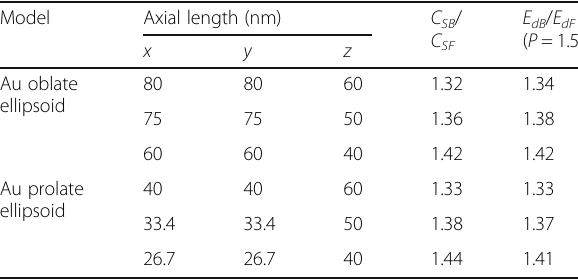
Table 4 Simulated C SB / C SF and calculated E dB / E dF using Eq. (4) when P equals 1.5 of different sizes, shapes of Au NPs when n 2 fixed as